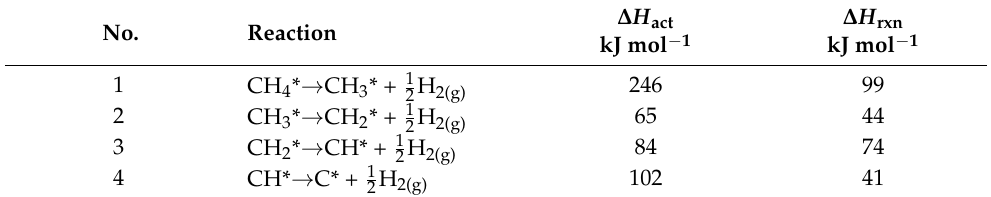
Table 2. DFT-predicted forward activation enthalpy ( ∆ H act = H TS − H reactants ) and enthalpy of reaction ( ∆ H rxn = H products − H reactants ) for methane dehydrogenation reactions on Ni 2 P(001) at 1123